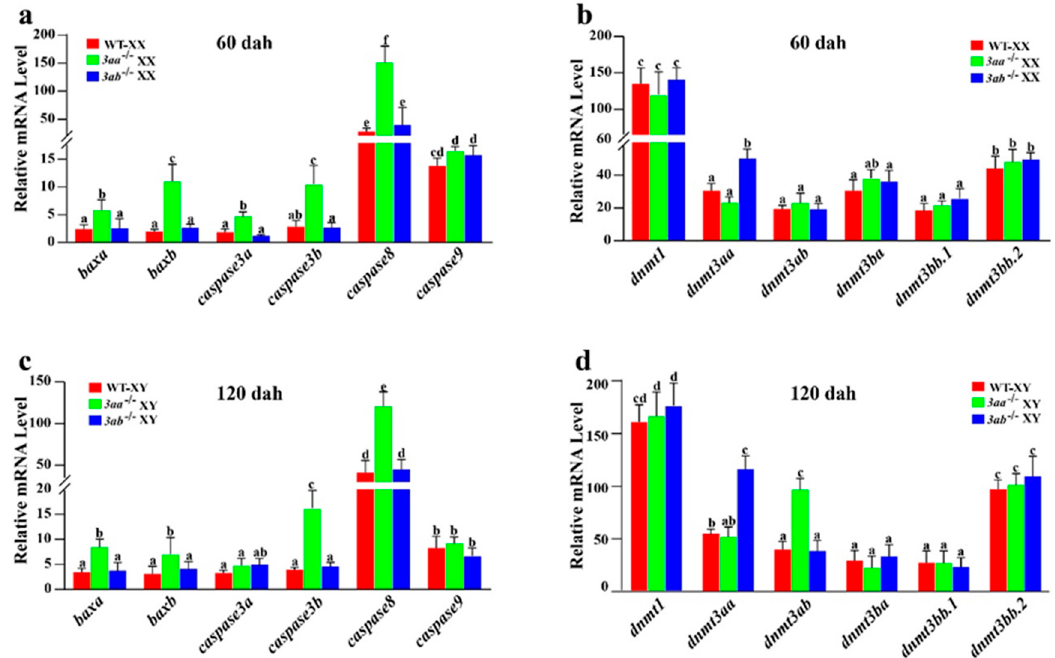
Figure 8. Detection of apoptosis genes and analysis of compensatory expression of dnmt family genes in dnmt3aa − / − and dnmt3ab − / − fish at 60 dah ( a , b ) and 120 dah ( c , d ). WT, wild type. The reference gene gapdh was used to normalize the expression values. Results are presented as mean ± SD. Different letters above the error bar indicate statistical differences at p < 0.05 as determined by one-way ANOVA followed by Tukey’s post hoc test. dah, days after hatching.